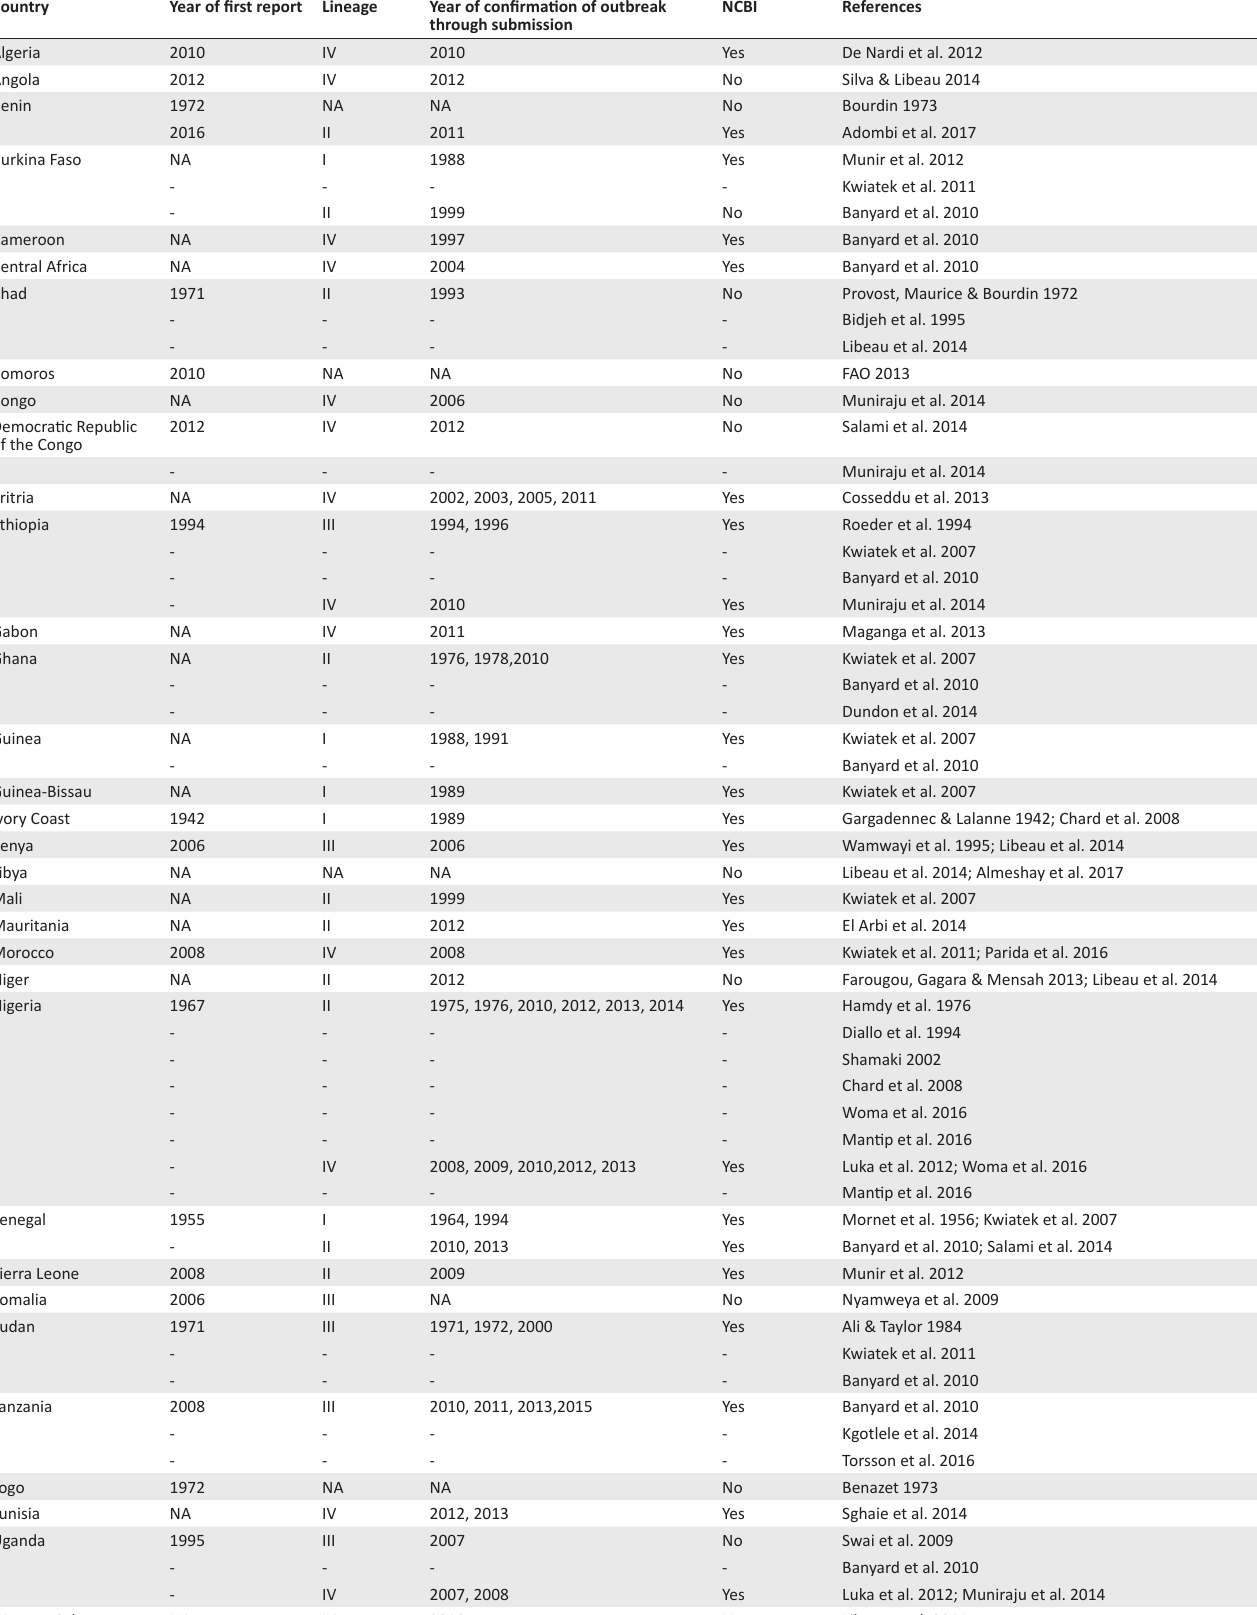
TABLE 1: Lineages of peste des petits ruminants virus circulating in different countries of Africa, based on partial N/F gene sequence analysis.